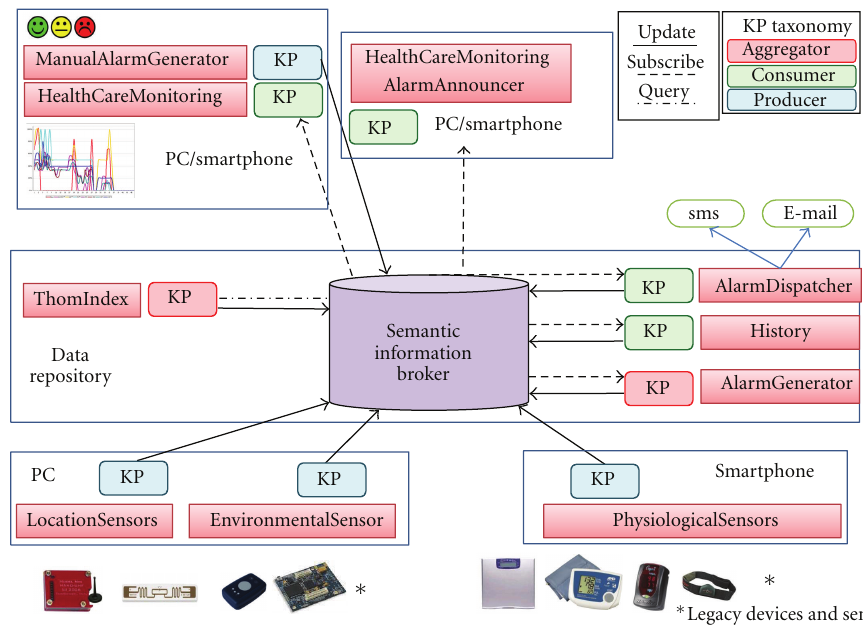
Figure 6: Interaction between